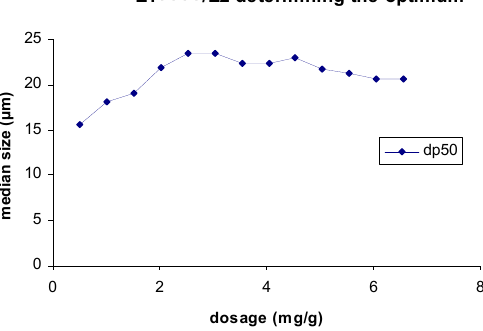
E1++++/E2 determining the optimum